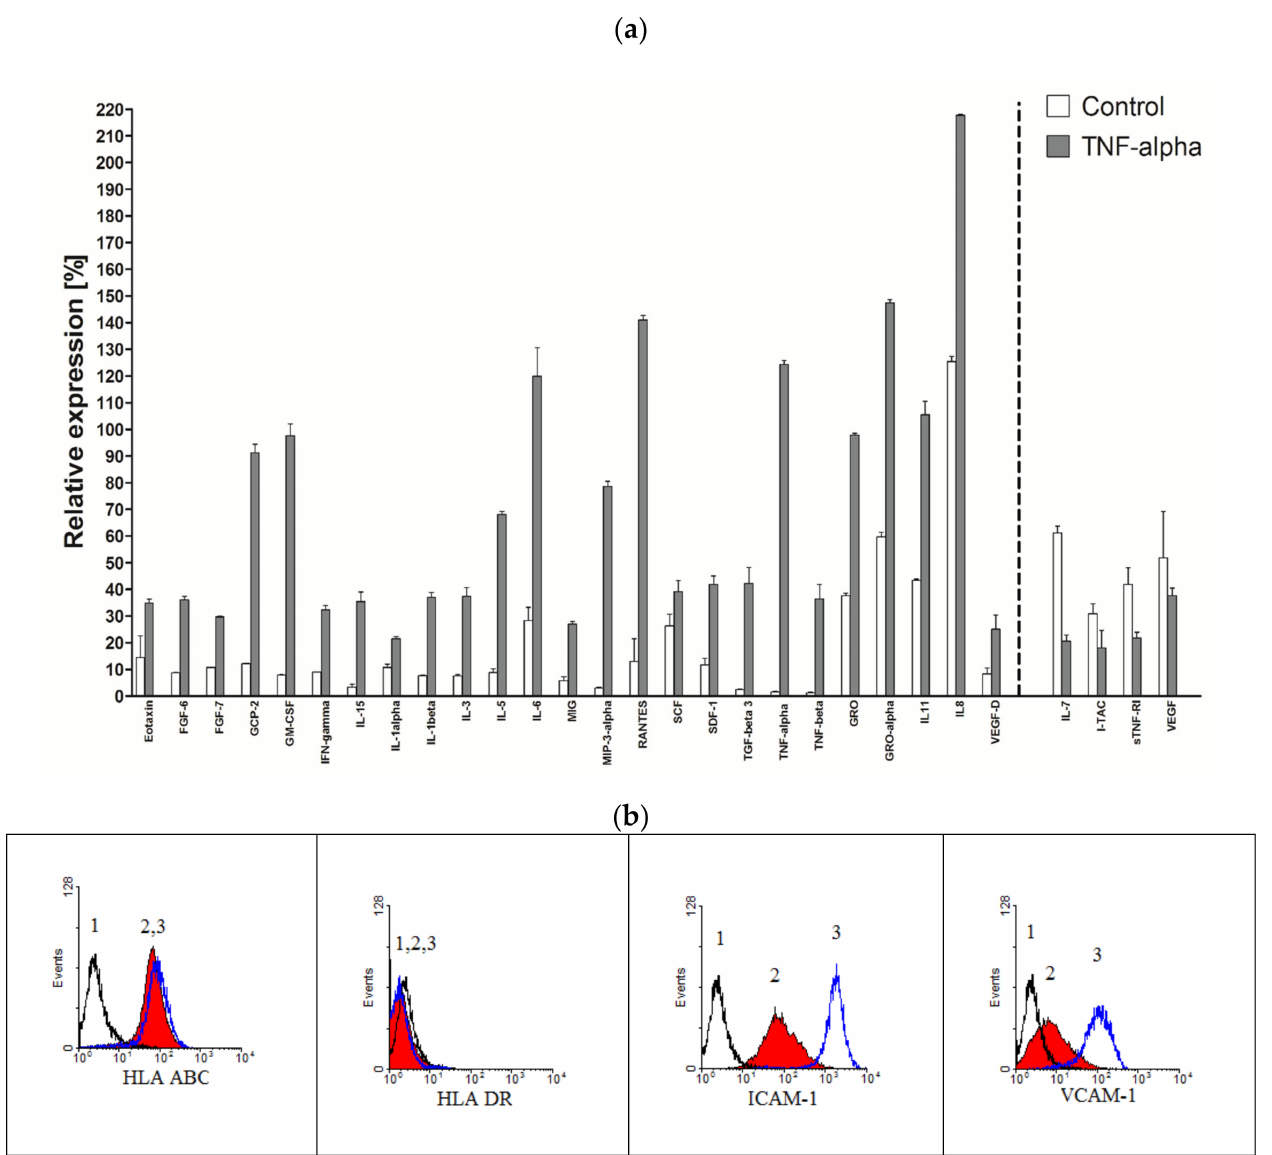
Figure 8. Selected cytokine production after a 24 h TNF-alpha stimulation of cell culture. ( a ) The secretory profile of Table 120, cytokines and expressed as a histogram relative to a positive control. Cell cultures were established and stimulated with 50 µ g/mL of TNF-alpha to receive supernatants. The data represent the mean from a duplicate assessment ± SEM; ( b ) Expression of histocompatibility markers and markers related to adhesion on HATMSC1 cells after TNF-alpha stimulation (1—isotypic control, 2—unstimulated cells, 3—cells stimulated with